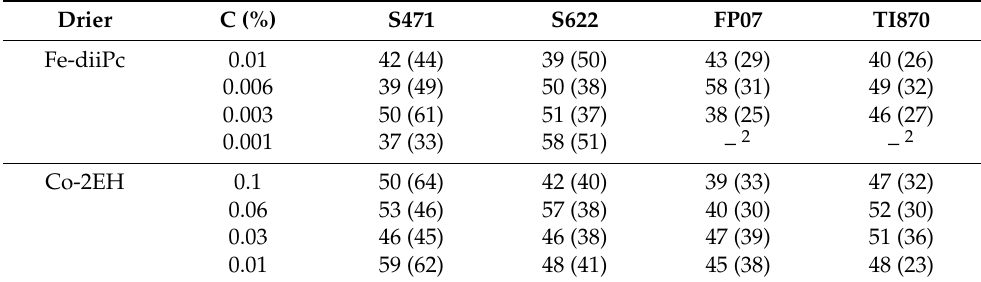
Table 3. MEK resistance for a given alkyd binder 1